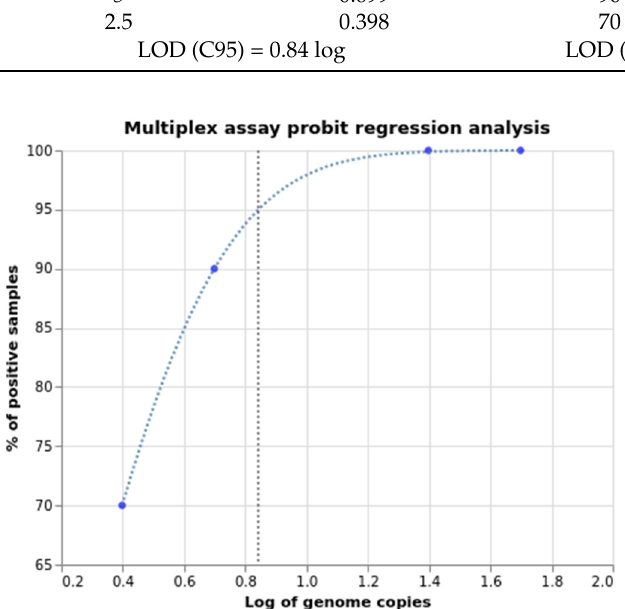
Figure 5. Probit regression model of the multiplex assay LOD.